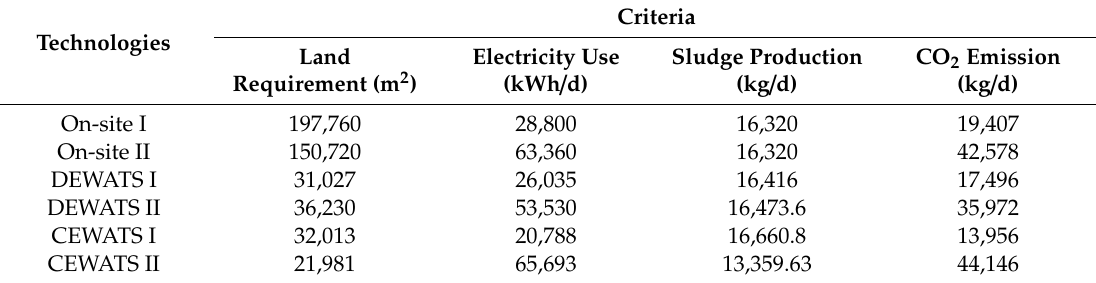
Table 3. Estimated results of the four criteria for the six wastewater treatment